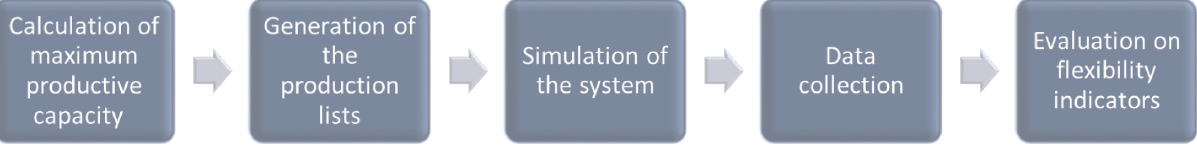
Figure 3. 5-step